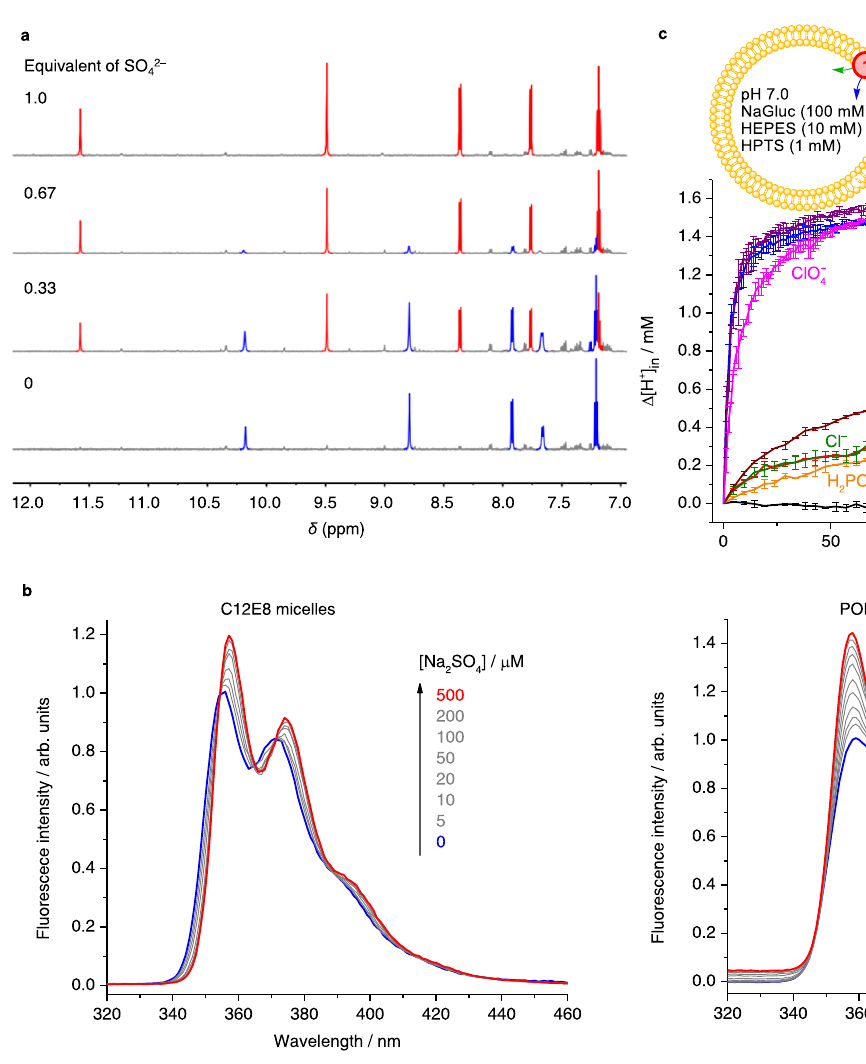
symport (in fl ux) facilitated by 1 (1mol%) upon the external addition of a NaX (20mM) salt in NaGluc vesicles buffered at pH 7.0 with 10mM HEPES. Error bars represent SD from two experiments. C12E8 octaethylene glycol monododecyl ether, POPC 1-palmitoyl-2-oleoyl-sn-glycero-3-phosphocholine, NaGluc sodium gluconate, HEPES 4-(2-hydroxyethyl)-1-piperazineethanesulfonic acid, HPTS 8-